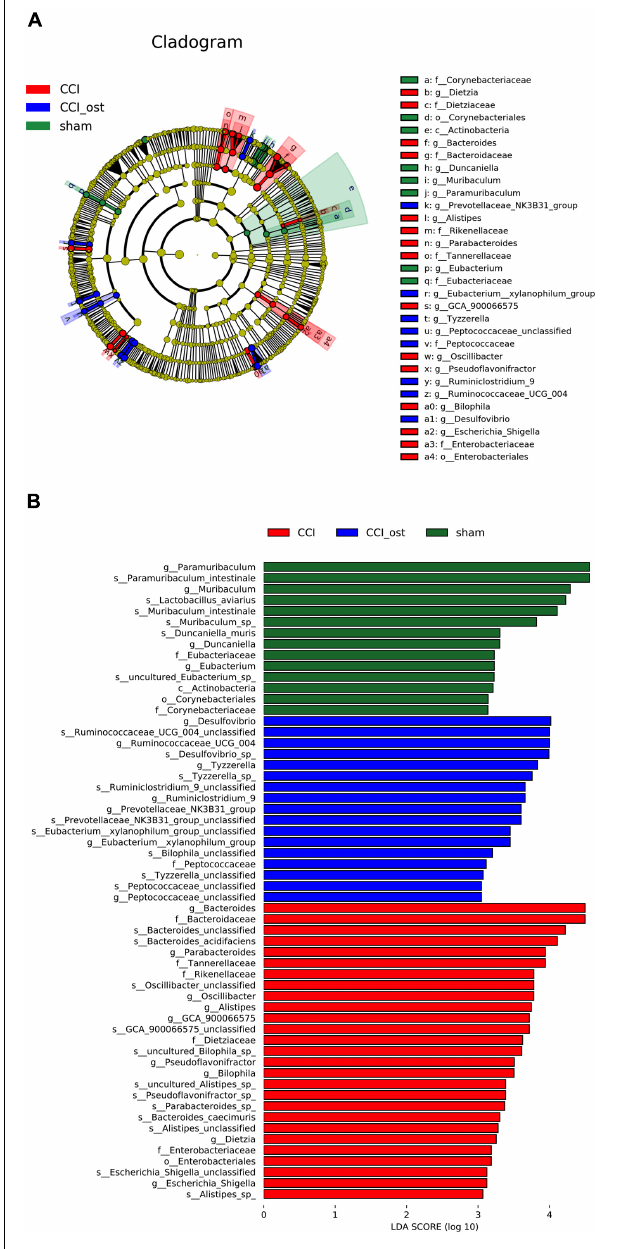
FIGURE 4 | Identification of most specific bacterial taxa by LEfSe analysis. Comparison of gut microbiota composition among experimental groups based on linear discriminant analysis (LDA) effect size (LEfSe) (A) and LDA (B) . Dot sizes are proportional to the abundance of certain taxa in the taxonomic cladogram, and the greatest differences among groups after LDA using a threshold score of > 4.0.